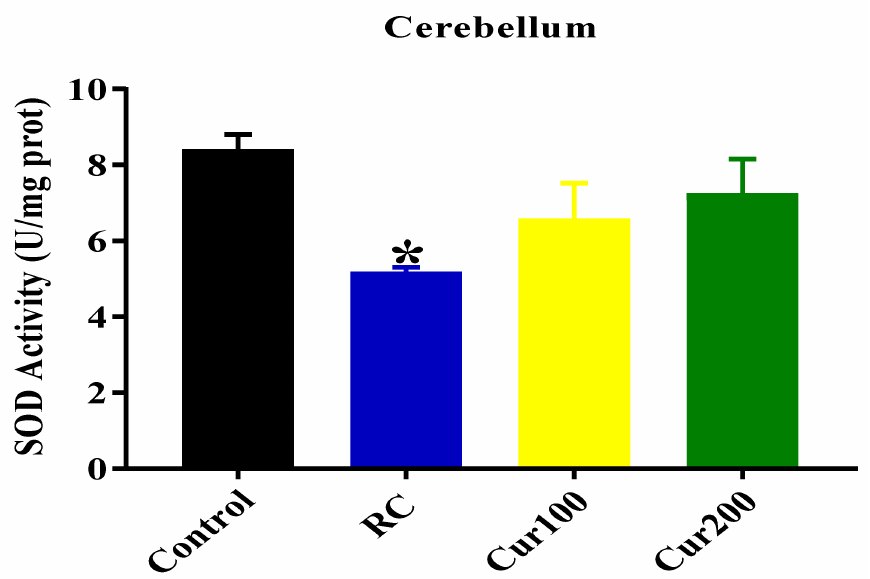
Figure 12. E ff ect of curcumin on superoxide dismutase (SOD) activity in the cerebellums of Pb-induced rats. Data are expressed as mean ± SEM ( n = 3); * p < 0.05 vs. control. MDA Level